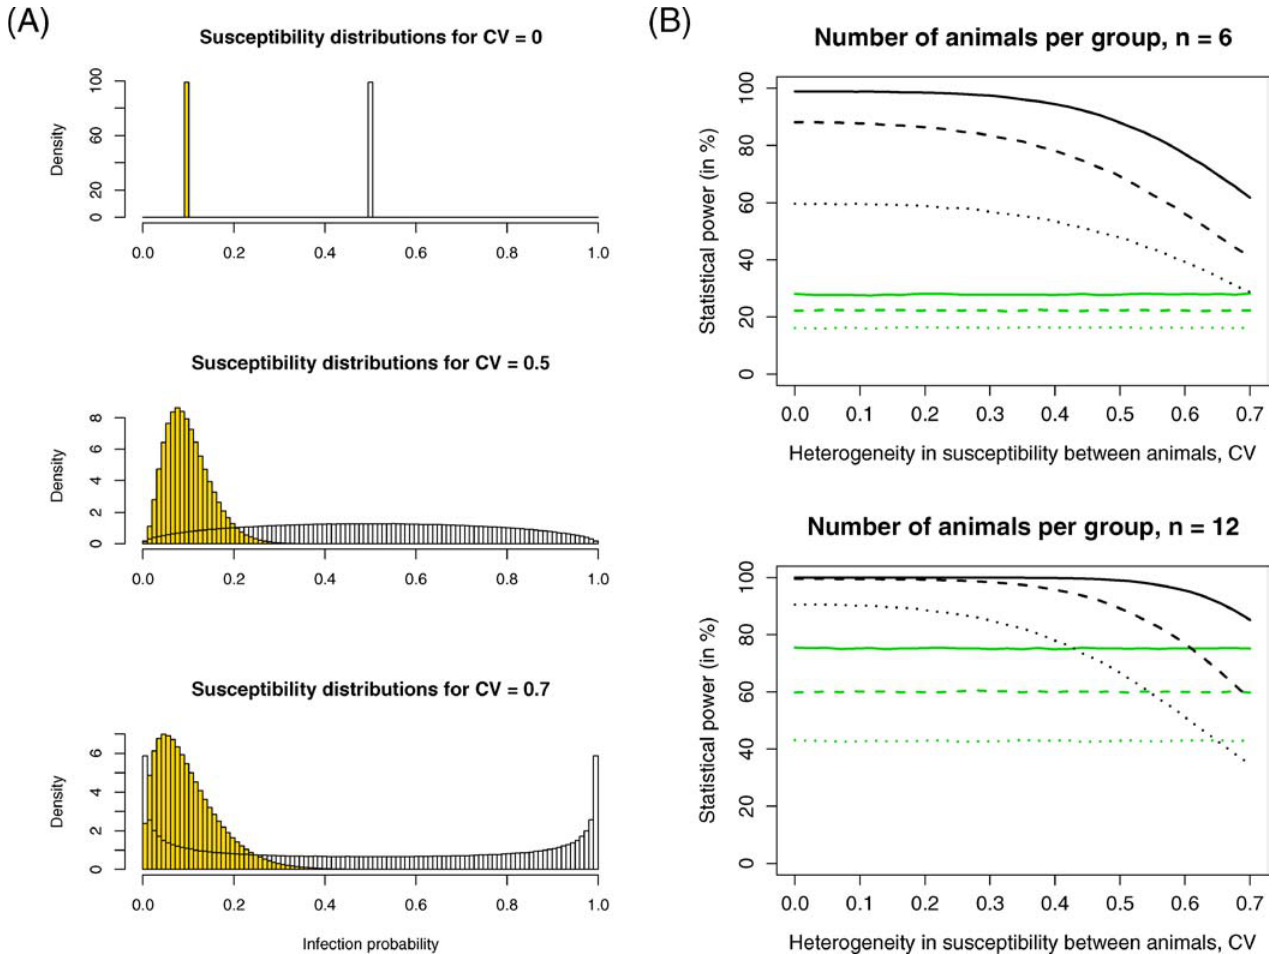
Figure 4. Impact of Heterogeneity in Susceptibility on the Statistical Power (A) Susceptibility distributions for different levels of heterogeneity, measured by the coefficient of variation, CV, of the susceptibility distribution. The vaccine is assumed to be 80% effective, VE S ¼ 0.8. (B) The statistical power depends on the coefficient of variation, CV, for the repeated low-dose challenge design (black lines) and the single low-dose challenge design (green lines). For these plots we assumed trials with six and 12 animals per group and vaccine efficacies of VE S ¼ 0.67 (dotted lines), VE S ¼ 0.8 (dashed lines), and VE S ¼ 0.9 (solid lines). DOI: 10.1371/journal.pmed.0020249.g004